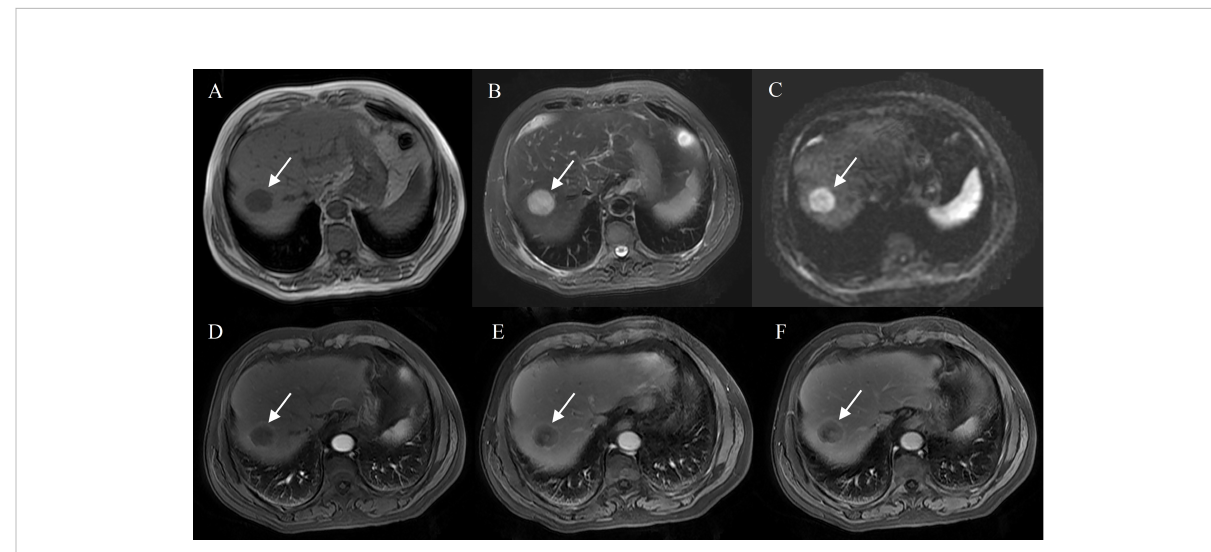
FIGURE 3 Hepatocellular carcinoma with peripheral rim enhancement in a 70-year-old male with hepatitis B virus. Gd-DTPA-enhanced MRI detected a round and smooth tumor (4.8 cm) with heterogeneous SI on T1WI and T2WI (A, B) , restricted diffusion (C) . Peripheral rim-like enhancement in the arterial phase (D) , complete capsule enhancement on portal venous phase (E) and delayed phase images (F) .